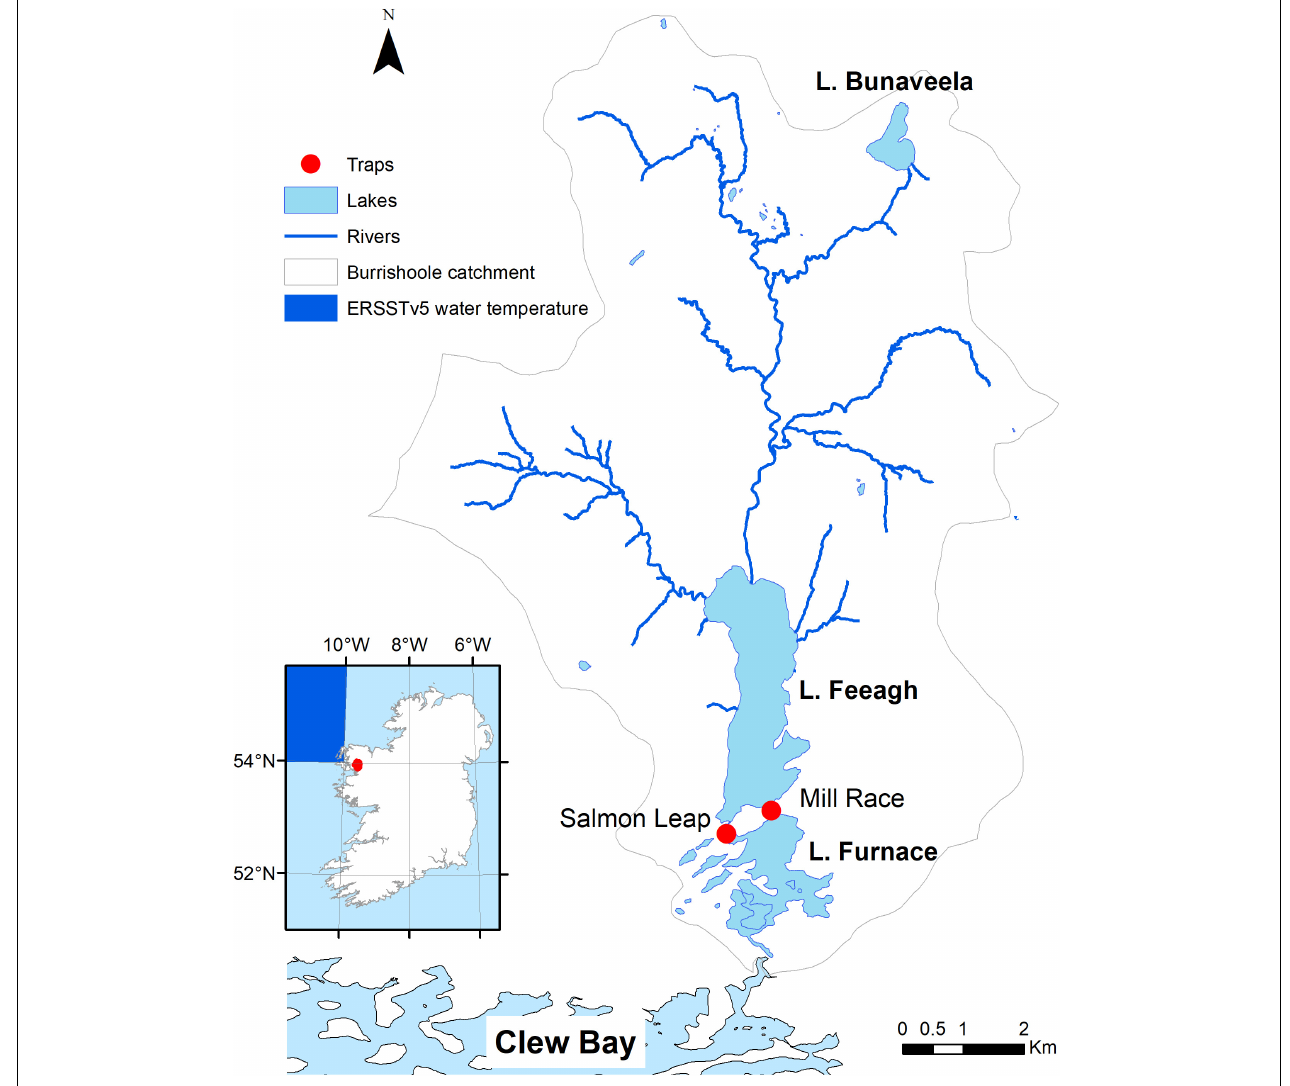
FIGURE 1 | Location of the Burrishoole catchment on the west coast of Ireland. Everything upstream of the red dots (representing the fish traps) is freshwater, while downstream (including lough Furnace) are coastal waters. The Met Éireann weather station are at the same location as the Mill Race trap (red dot). The blue square in the inset map indicates the area for which we extracted the oceanic water